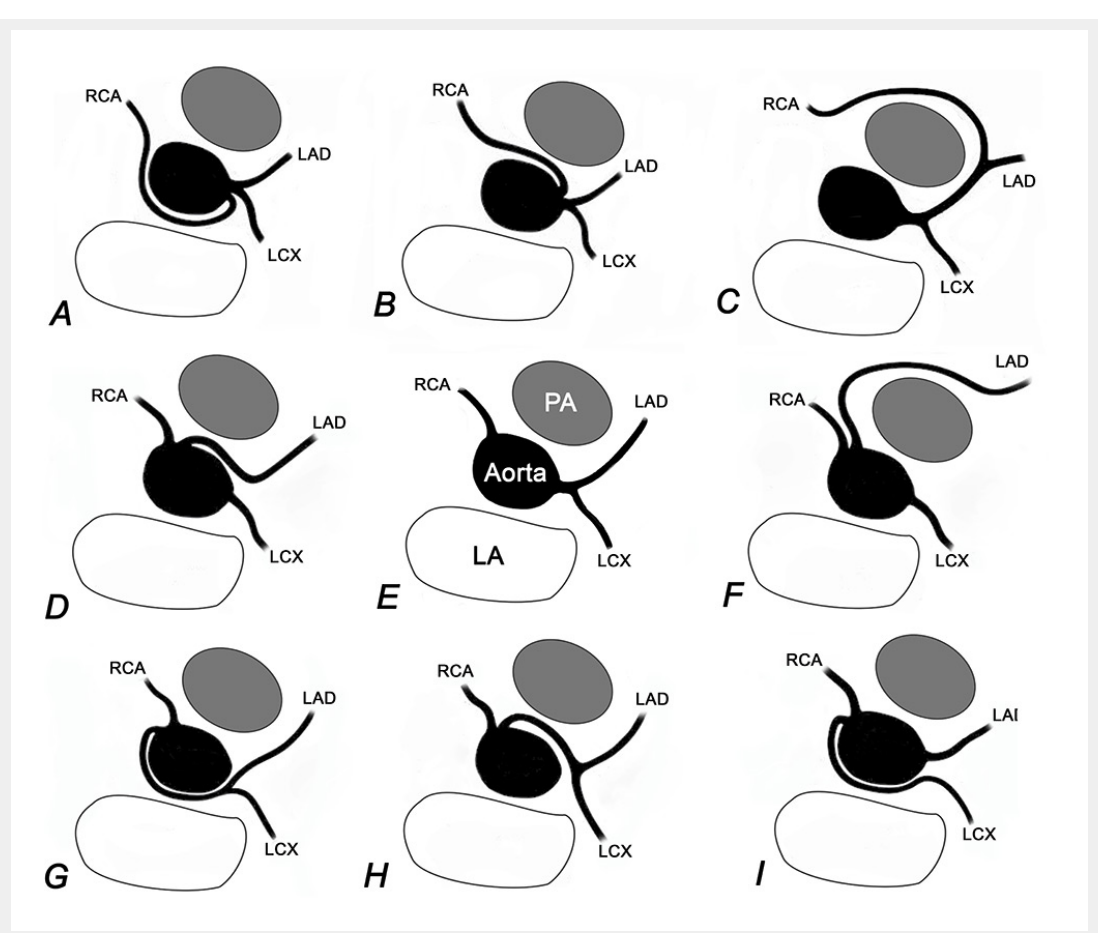
Schematic illustration of a selection of coronary artery anomalies. For comparison, the normal anatomical situs is given in the middle (i.e., Panel E). A: ACAOS with RCA originating from the LCS with a retroaortic course. B: ACAOS with RCA originating from the LCS with an interarterial course. C: “Single left” coronary artery with a RCA originating from the LAD and a prepulmonic course. D: ACAOS with LAD originating from the RCS with an interarterial course. F: ACAOS with LAD originating from the RCS with a prepulmonic course. G: ACAOS with LM originating from the RCS with a retroaortic course. H: ACAOS with LM originating from the RCS with an interarterial course. I: ACAOS with LCX originating from the RCS with a retroaortic course. ACAOS = anomalous coronary arteries originating from the opposite sinus of Valsalva; LAD = left anterior descending artery; LCS = left coronary sinus; LCX = left circumflex coronary artery; LM = left main stem; RCA = right coronary artery; RCS = right coronary